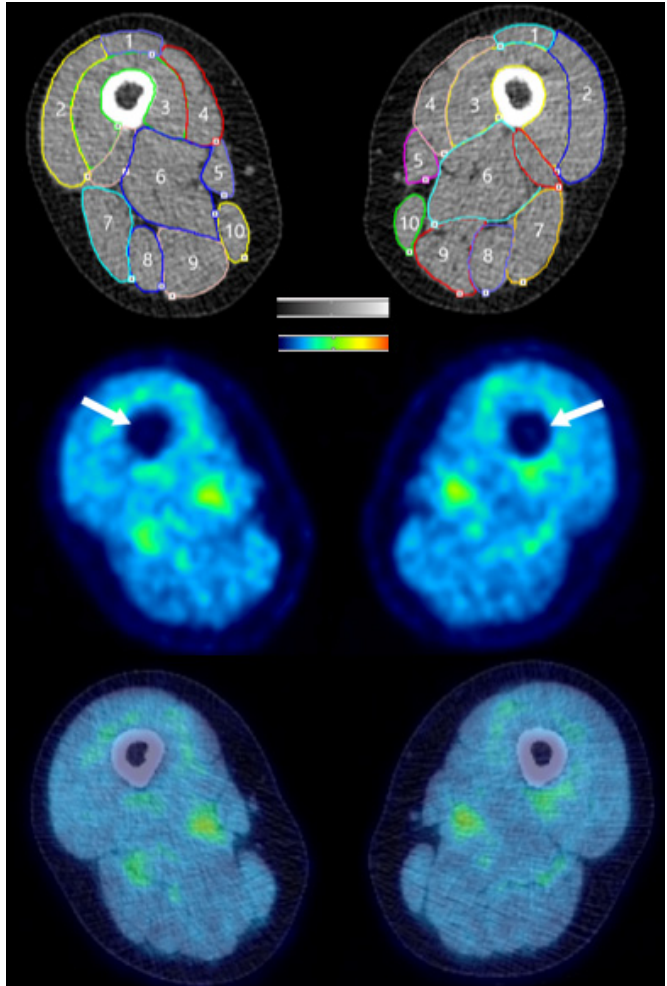
Figure 2. Cross-sectional slice of a CT scan taken at the mid-thigh level in Subject 4. Regions of interest (ROIs) were drawn on the computer tomography (CT) scan (top image) to indicate the different skeletal muscles of the lower limb. 1 = Rectus Femoris, 2 = Vastus Lateralis, 3 = Vastus Intermedius, 4 = Vastus Medialis, 5 = Sartorius, 6 = Adductor Magnus (not included in the analysis), 7 = Biceps Femoris, 8 = Semitendinosus, 9 = Semimembranosus, 10 = Gracilis. The ROIs were copied to the corresponding positron emission tomography (PET) image (middle image). The white arrows indicate the femur in the middle image. The bottom image is an example of a PET scan co-registered to a CT scan. Red denotes the greatest signal intensity, followed by yellow, green, and blue.